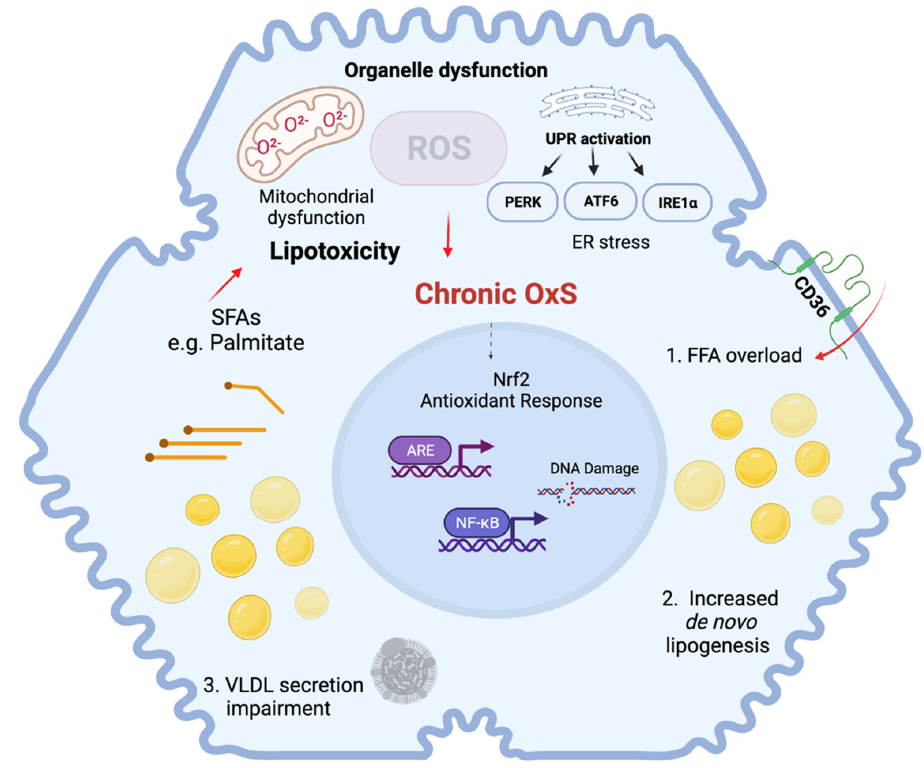
Figure 1. Oxidative Stress-related molecular mechanisms involved in NAFLD pathophysiology.In NAFLD, there is an excessive accumulation of lipid droplets in hepatocytes due to (1) FFA overload, caused by increased lipid uptake from diet and/or adipose tissue, (2) Elevated de novo lipogenesis and (3) Impairment of VLDL secretion. Excess FFAs, specifically SFAs, e.g., palmitate, trigger oxidative stress via direct and indirect mechanisms. Organelle dysfunction, such as ER stress and mitochondrial dysfunction, is a hallmark of NAFLD and further contributes to increased ROS produc- tion, leading to the activation of antioxidant and anti-inflammatory responses, such as the